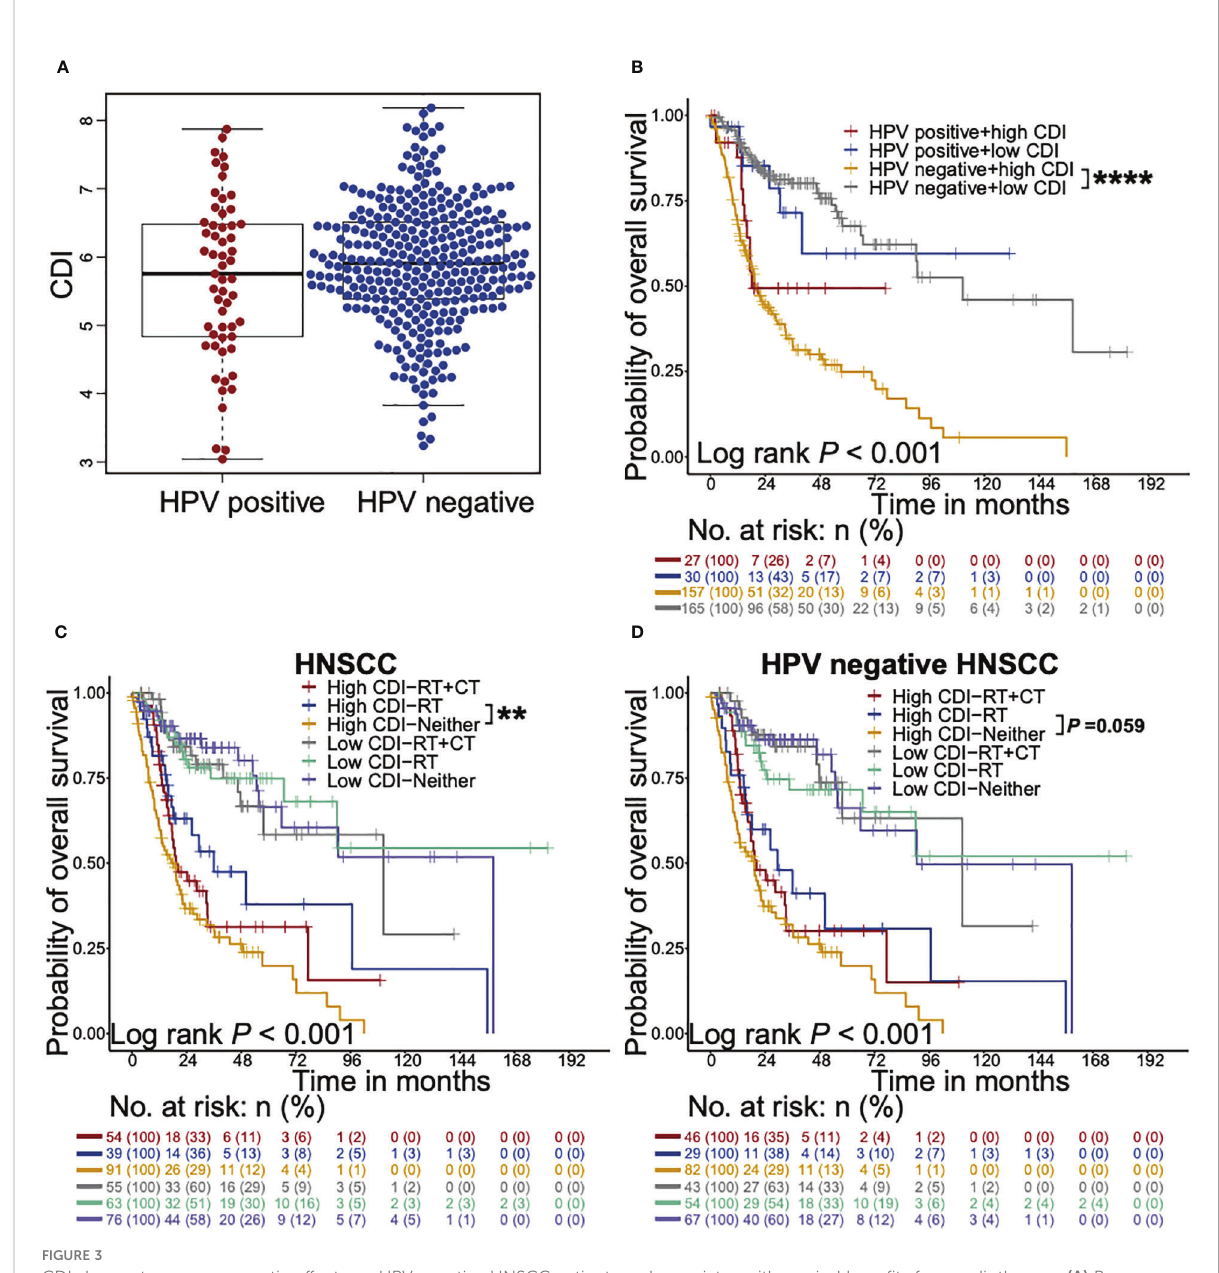
FIGURE 3 CDI shows stronger prognostic effects on HPV negative HNSCC patients and associates with survival bene fi ts from radiotherapy. (A) Beeswarm plot shows the differences of CDI distribution between HPV positive and HPV negative patients in TCGA cohort. The statistical signi fi cance is assessed by Wilcoxon test. (B) Kaplan-Meier survival curves illustrate the overall survival probabilities of HNSCC patients strati fi ed according to CDI scores and HPV status (**** P < 0.0001, log-rank test). (C, D) Kaplan-Meier survival curves illustrate the overall survival probabilities of patients with different CDI scores receiving chemoradiotherapy, radiotherapy alone or neither of them in HNSCC patients (C) and HPV negative HNSCC subgroup (D) (** P < 0.01, log-rank test). HNSCC: head and neck squamous cell carcinoma; CDI: cell death index; HPV: human papillomavirus; RT: radiotherapy; CT: chemotherapy. ** P < 0.01, **** P <